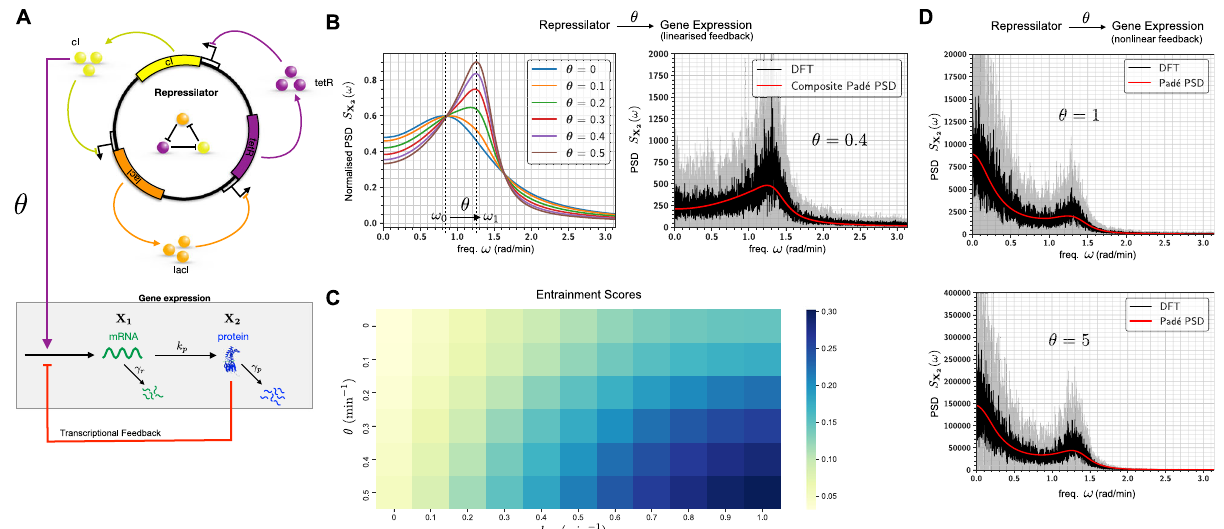
Fig. 5 Stochastic entrainment of gene expression by the repressilator. A Schematic diagram of the repressilator driving a gene expression network. The cI protein from the repressilator acts as an activating transcription factor for mRNA ( X 1 ) which translates into output protein ( X 2 ). The red arrow from X 2 to X 1 indicates negative transcriptional feedback from the protein molecules. When the repressilator is connected to the gene expression network, for linearised feedback the PSD can be estimated with the composite Padé PSD method which is based on Theorem 2.1. In B , these PSD estimates (after normalisation by the total area under the PSD curve) are plotted for six values of θ and compared for θ ¼ 0 : 4min (cid:3) 1 to the PSD obtained with the DFT method. One can observe the stochastic entrainment phenomenon as θ increases. C The heat-map for the entrainment score (see (44)) as a function of θ and the feedback strength parameter k fb . Observe that the entrainment score is monotonically increasing in both variables k fb and θ , but it is more sensitive to k fb . D For nonlinear transcriptional feedback PSD estimates obtained with Padé PSD are plotted and compared with the DFT method for θ ¼ 1min (cid:3) 1 and θ ¼ 5min (cid:3) 1 . All the PSDs were estimated with Q = 10 simulated trajectories.